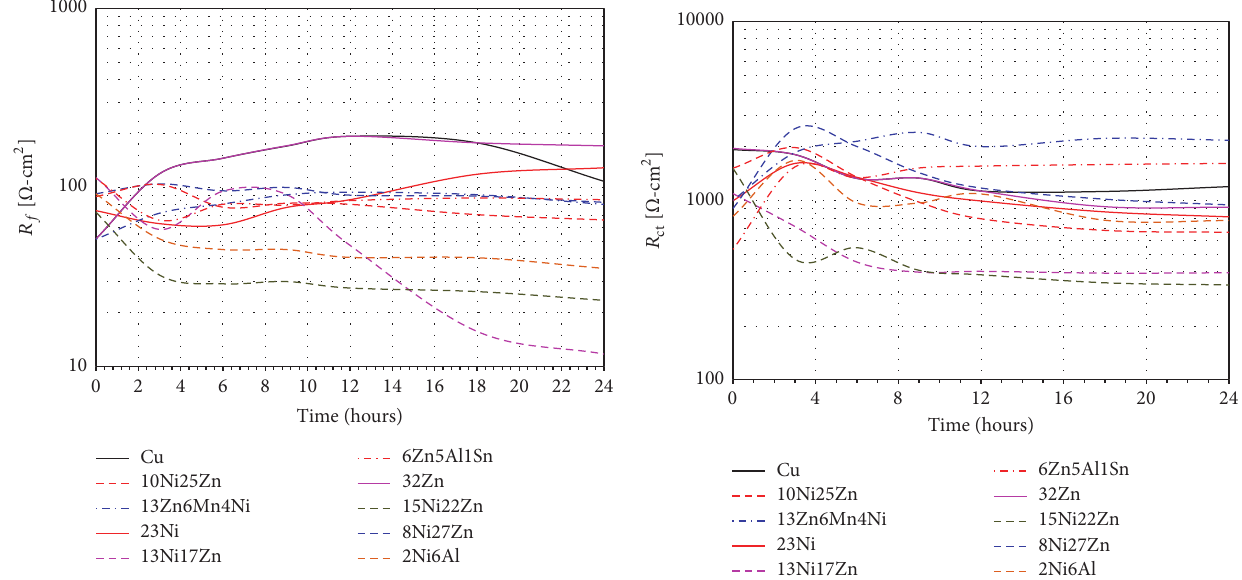
Figure 9: 𝑅 ct and 𝑅 𝑓 variation against time for Cu-based coins evaluated in artificial sweat at 37 ∘ C.